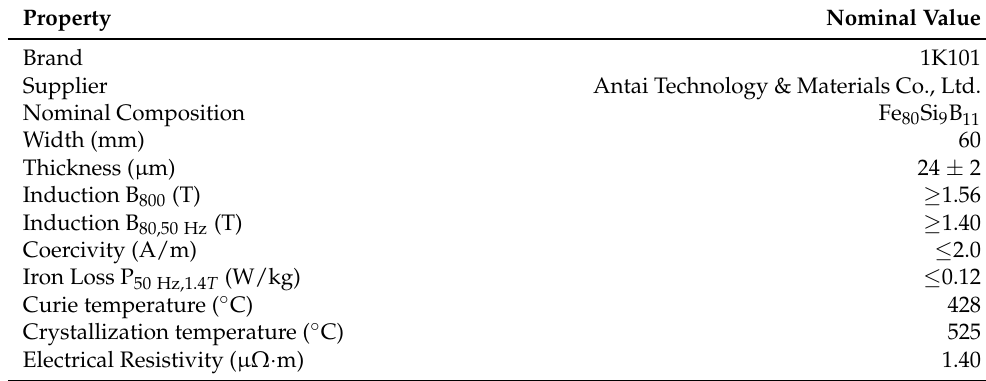
Table 1. Basic parameters of sample preparation